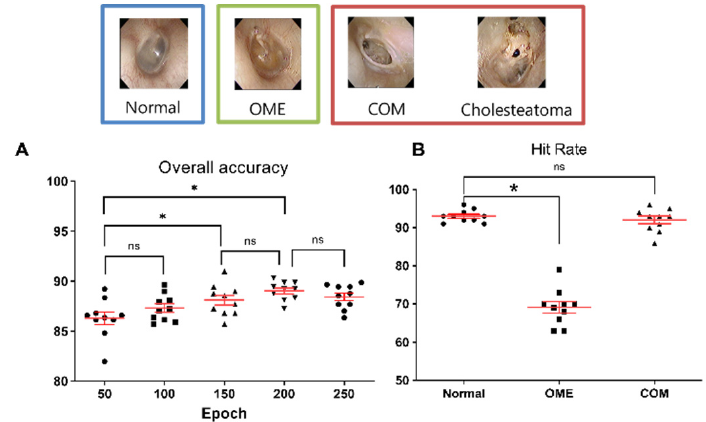
Figure 5. Accuracies and hit rates for differentiating between normal, otitis media with effusion, and chronic otitis media, including cholesteatoma. ( A ) Overall accuracy for the machine learning model, according to epoch. (* indicates p -value less than 0.05 with Mann–Whitney test, ns meant non-significant difference). ( B ) Mean hit rates for normal (93.0%), otitis media with effusion (69.1%), and chronic otitis media, including cholesteatoma (92.0).